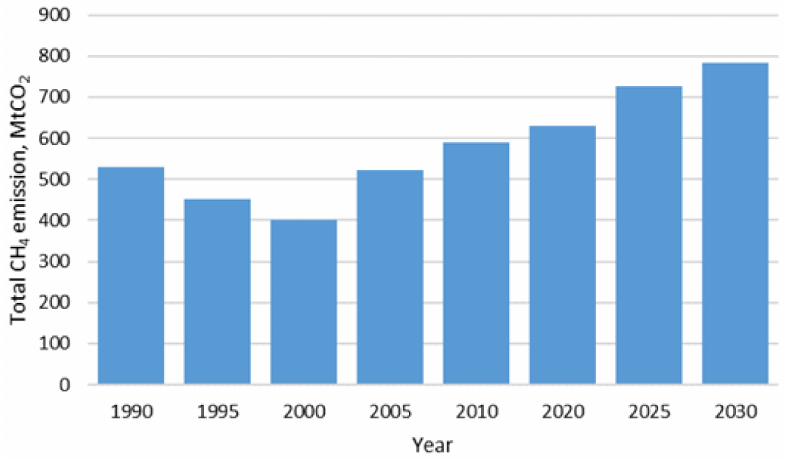
Figure 1. Total CH 4 Emissions from Coal Mining